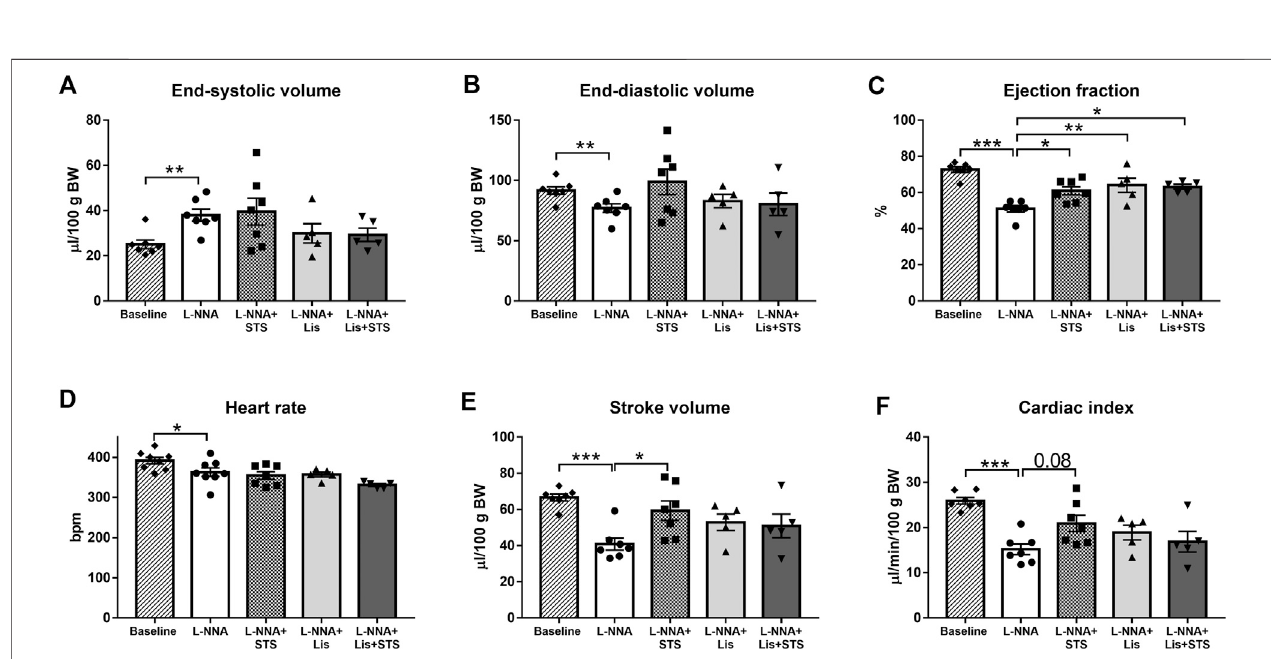
FIGURE2| TreatmentwithSTSimprovessystolicfunction. (A) End-systolicvolume and (B) end-diastolic volumeweremeasured tocalculate (C) ejectionfraction. (D) Heart rate and (E) stroke volume were used to calculate (F) cardiac index in the four groups. N (cid:2) 5 – 8. * p < 0.05, ** p < 0.01, *** p < 0.001.